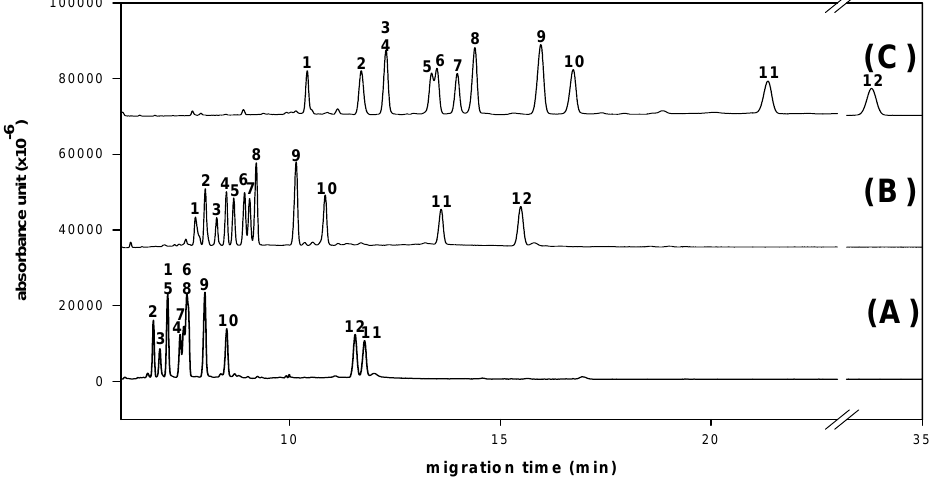
Figure 5. Effects of pH value of borate buffer on derivated monosaccharides separation. (A) pH 8.0 (B) pH 9.0 (C) pH 10.0. Peaks: 1= Rha-NAIM; 2=